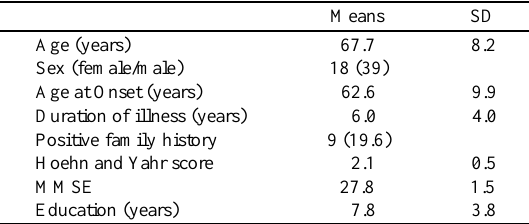
Table 1 Demographic and clinical features of the PD patients ( n =